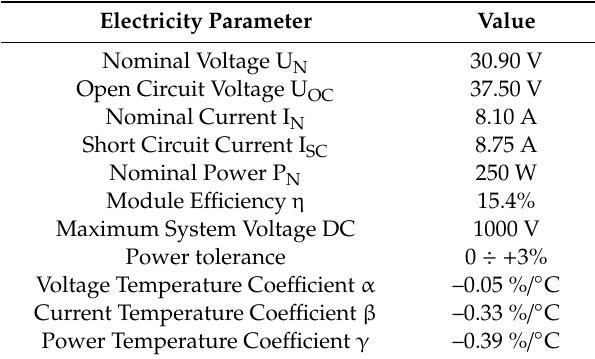
Table 1. Basic parameters of PV module SFE.MF-6-250.